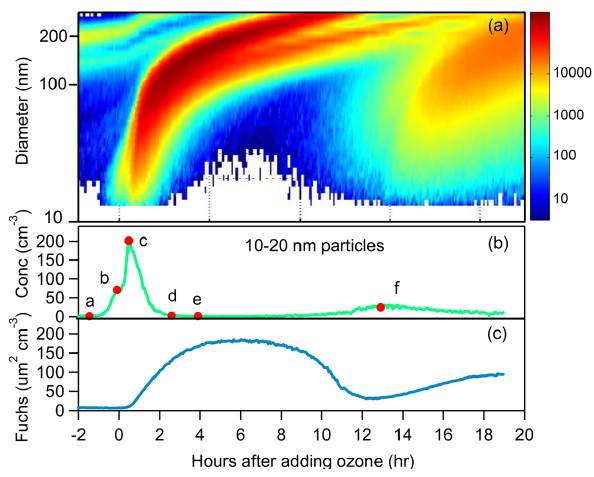
Fig. 1. Characteristics of particle formation from α -pinene ozonoly- sis for E1: (a) contour plot of the particle size distribution measured with the SMPS in the 10–350nm diameter range; (b) total num- ber concentration of particles between 10 and 20nm. Points a–f denote the corresponding characteristic times as indicated below: a ( t =− 1.7h), background levels; b ( t = 0h), addition of ozone; c ( t = 0.5h), reaching peak concentrations of Category I products for the first particle formation event; d ( t = 2.6h), disappearance of al- most all 10–20nm particles; e ( t = 3.9h), approaching steady-state concentration of Category I products; f ( t = 12.9h), reaching peak concentrations of Category I products for the second particle for- mation event (see text for the definition of Category I